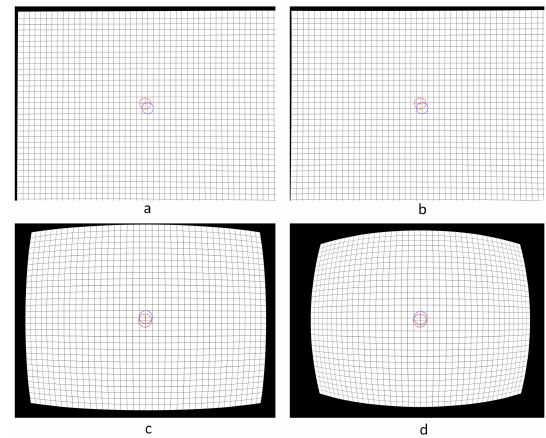
Figure 3. Distortion maps of camera systems. The red circle is the initial principle point, and the blue one is the calibrated principle point. (a) Lumix in air, (b) Lumix underwater, (c) GoPro in air, (d) GoPro underwater.